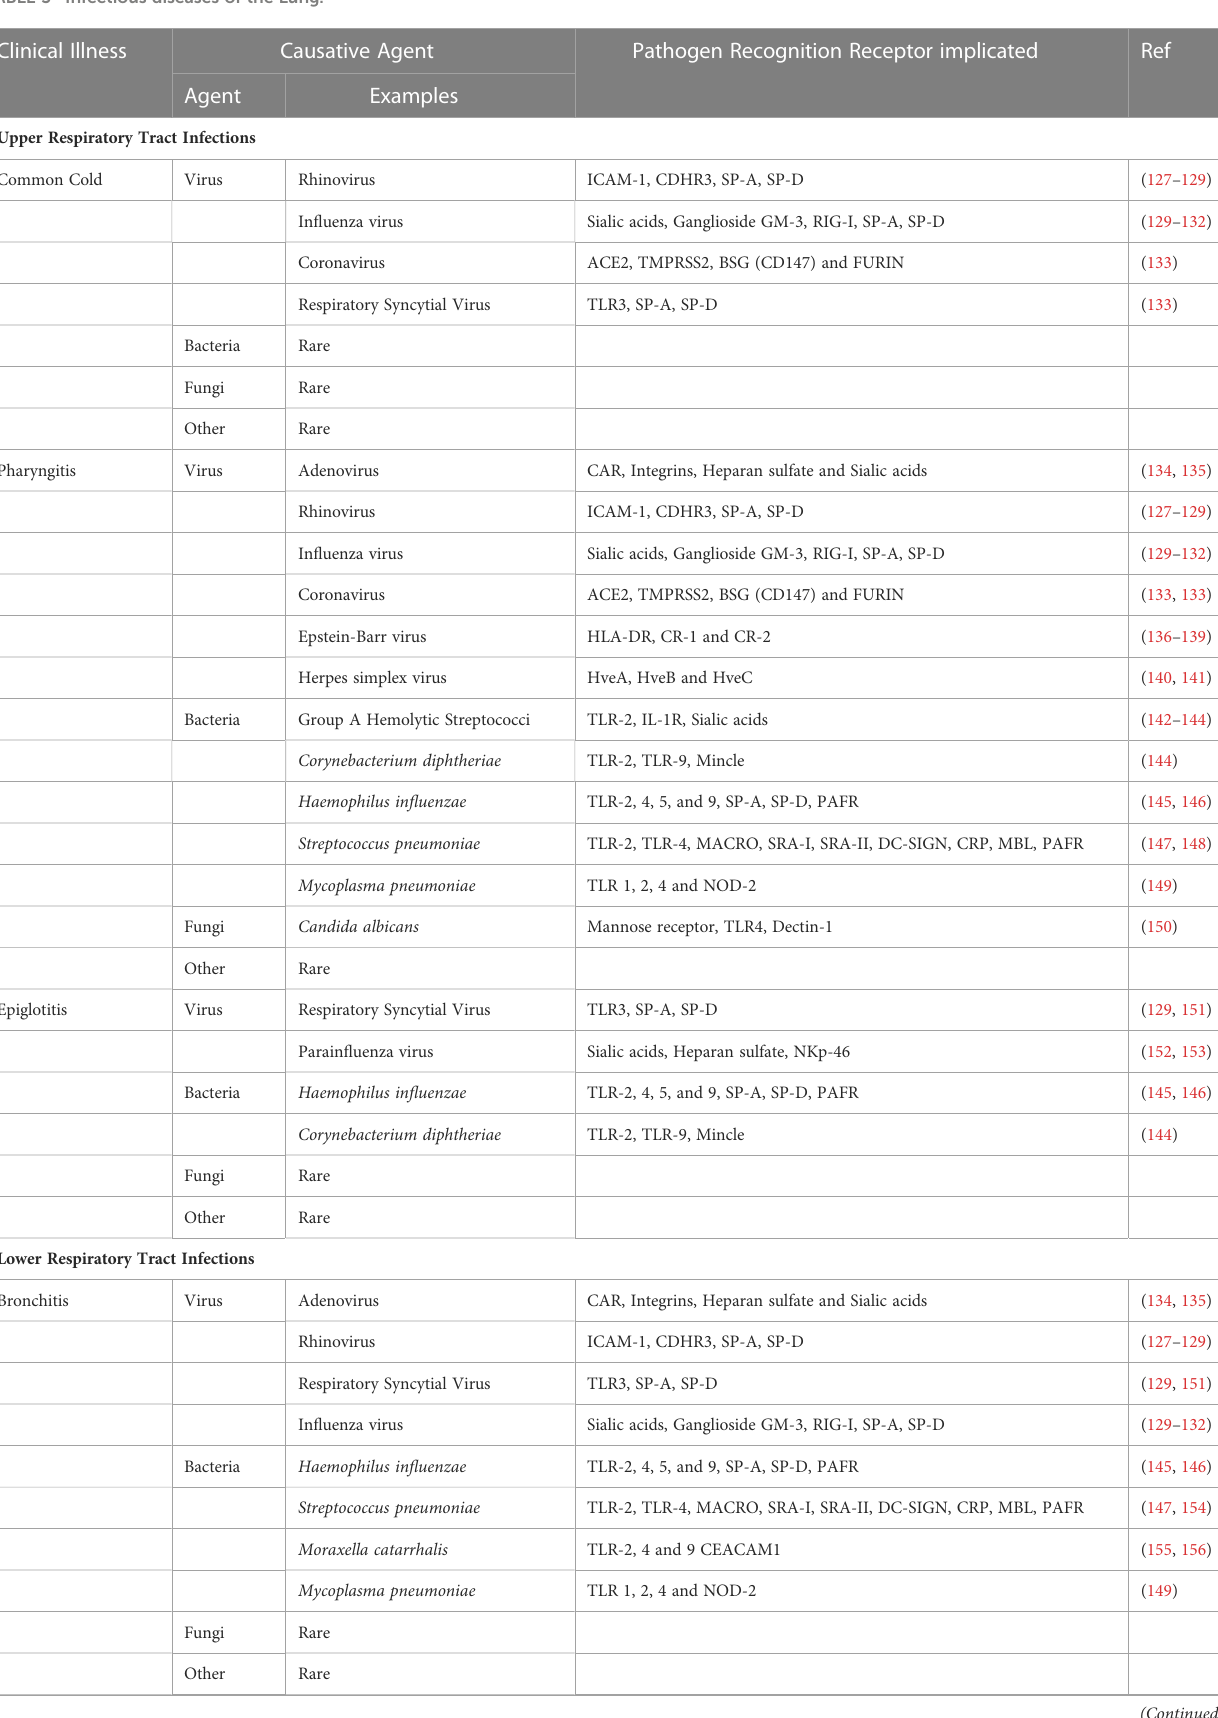
TABLE 3 Infectious diseases of the